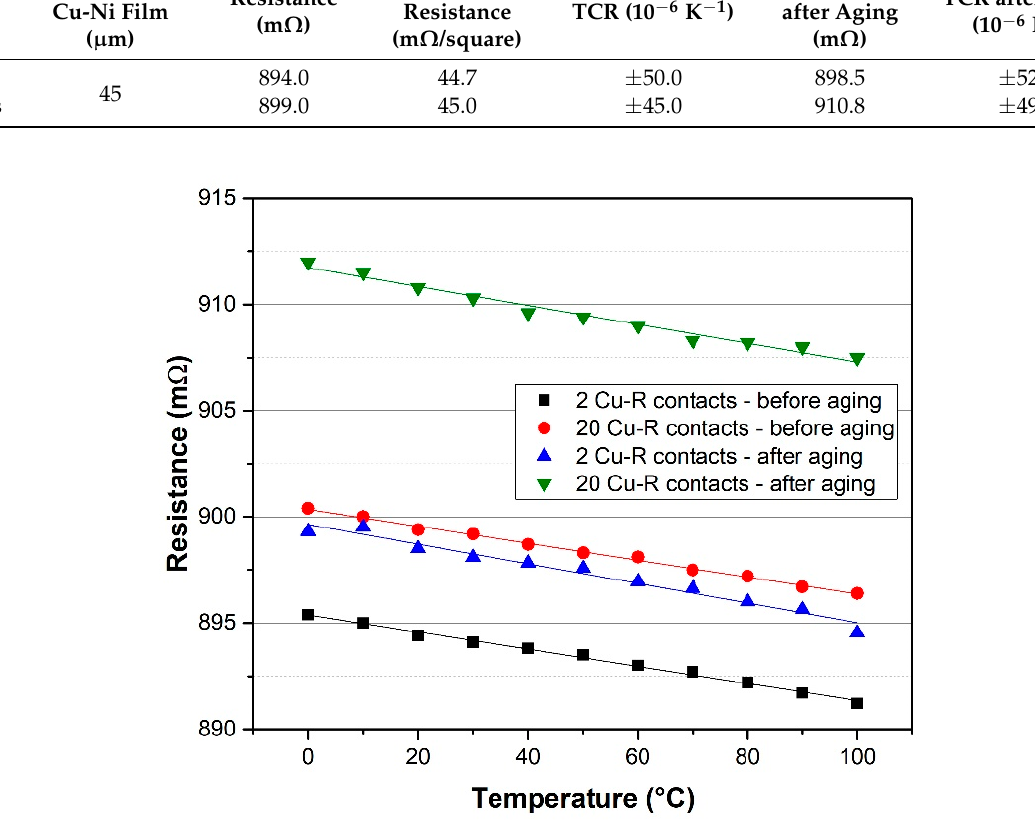
TRIS LS-9600TD with laser source X30SC-106QA (1064 nm/40 W, Nd: YV04@1mJ: 10–60 ns @ 1–500 kHz) with the following settings: laser power: 50%, pulse frequency 7 kHz, laser speed: 4 mm/s. Figure 8 shows the example of a copper-nickel resistor after laser trimming and an SEM image of the detailed morphology of a laser